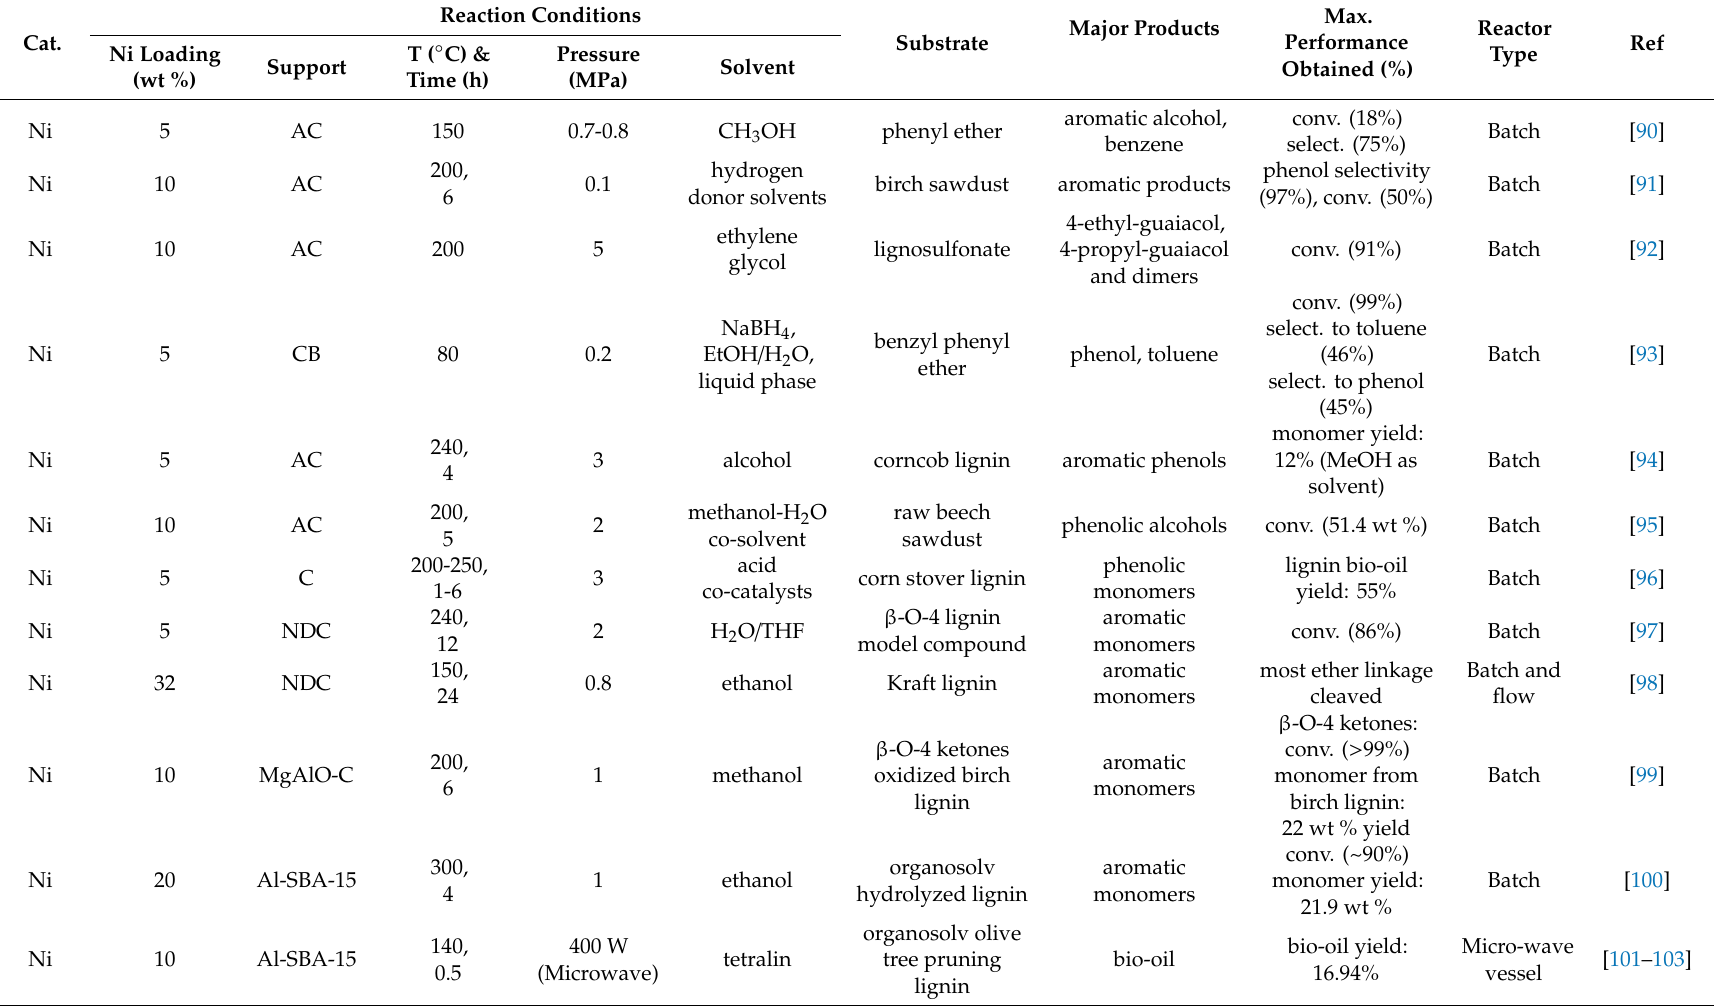
Table 5. Hydrogenolysis of lignin model compounds and lignin over monometallic and bimetallic Ni catalysts.